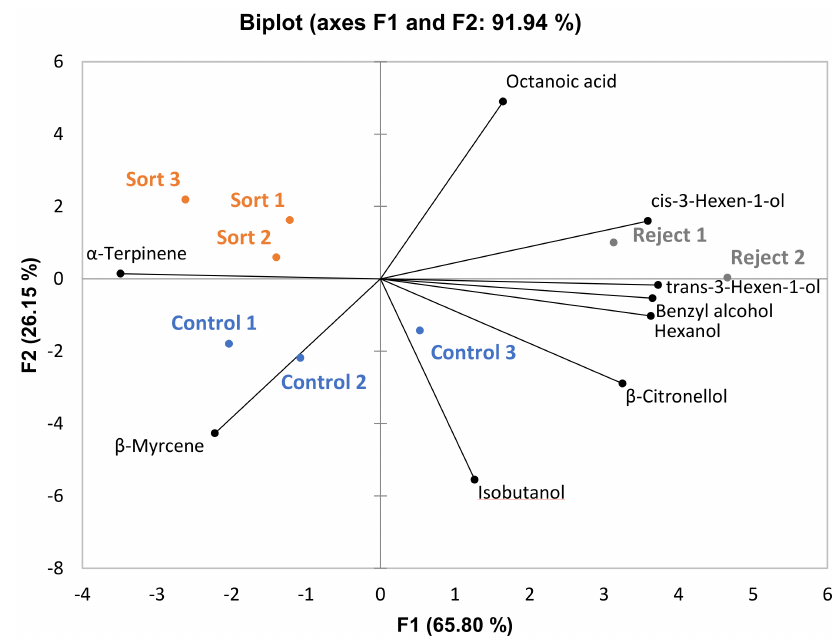
Figure 3. PCA biplot of volatile compounds that differed significantly among treatments for the Grenache wines ( p < 0.05, n = 3 for sort and control treatments, n = 2 for reject